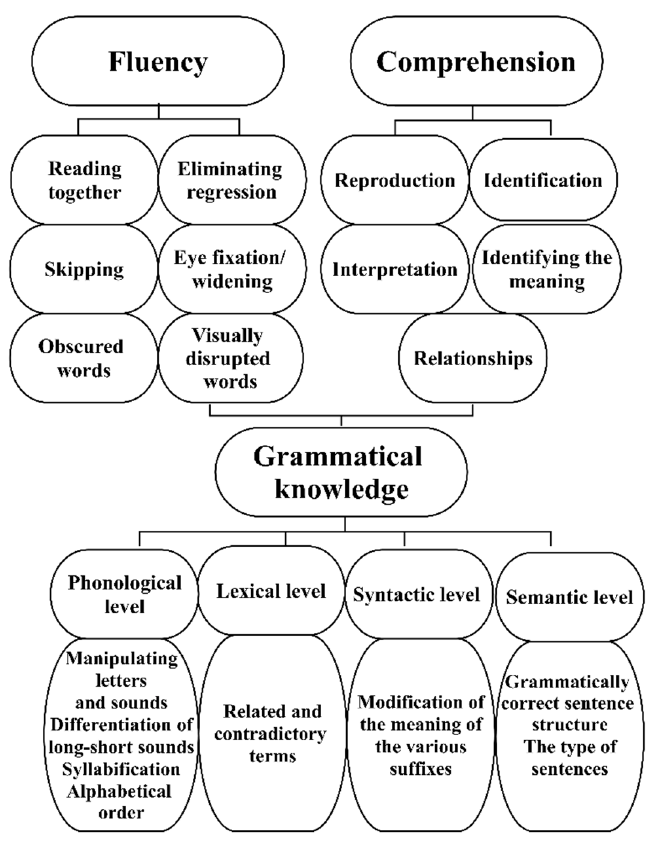
Figure 1. The complex structure of the development program (own editing).